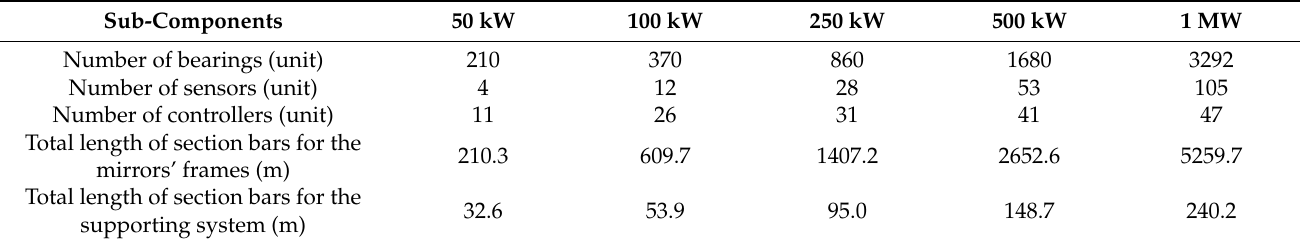
Table A2. Description of the elements for the optical system as a function of the size (in terms of input power) of the CSP